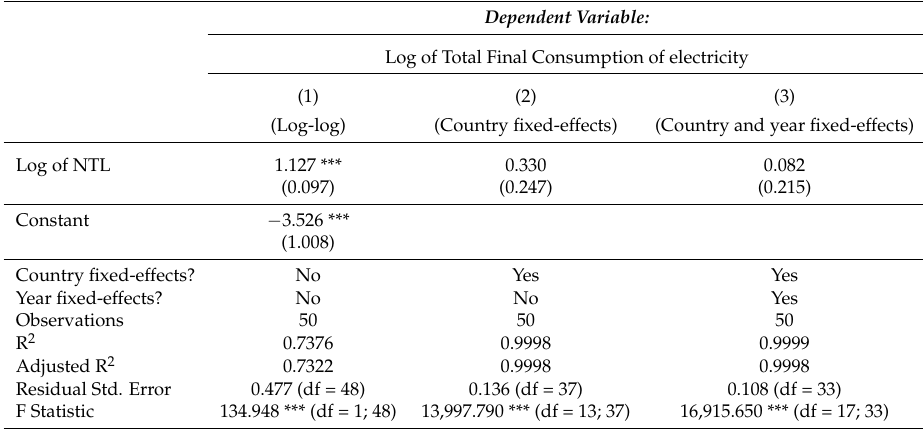
Table A6. Regression for RESIDENT—Low-income